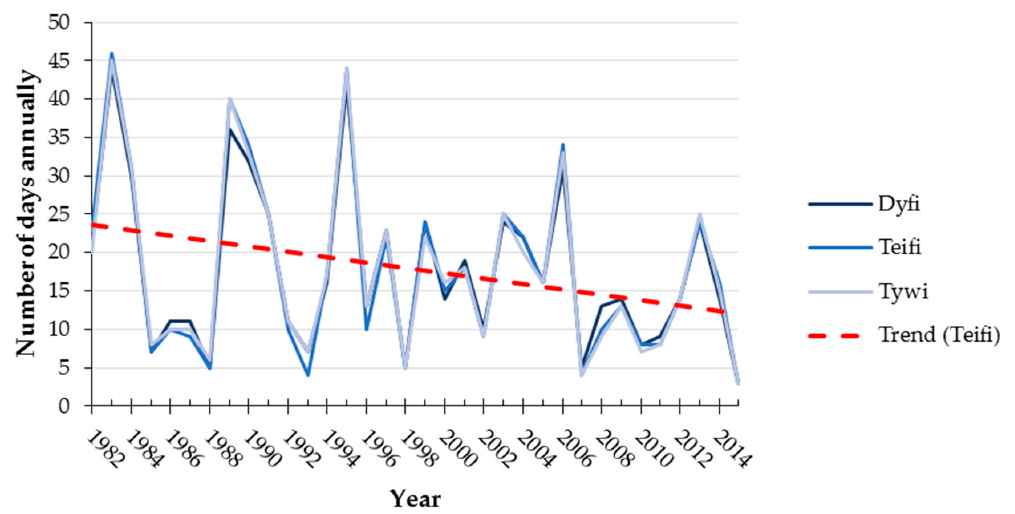
Figure 3. Number of occurrences annually where daily average temperature is greater than the 95th percentile temperature value for the full 34-year dataset. Linear trend for the Teifi catchment shown with red dashed line to exemplify the linear trend in all three catchments.